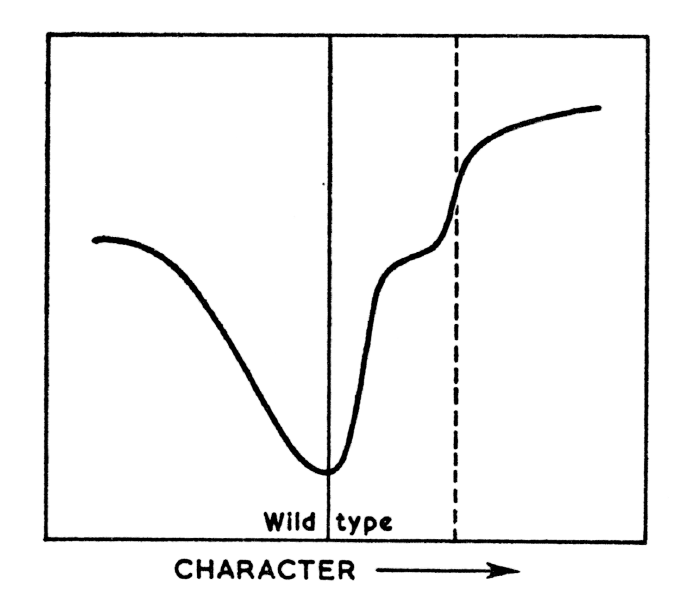
An Asymmetrical Canalisation Cross-Section , from Conrad H. Waddington, The Strategy of the Genes (London: Allen and Unwin, 1957), 128 (photo: author).